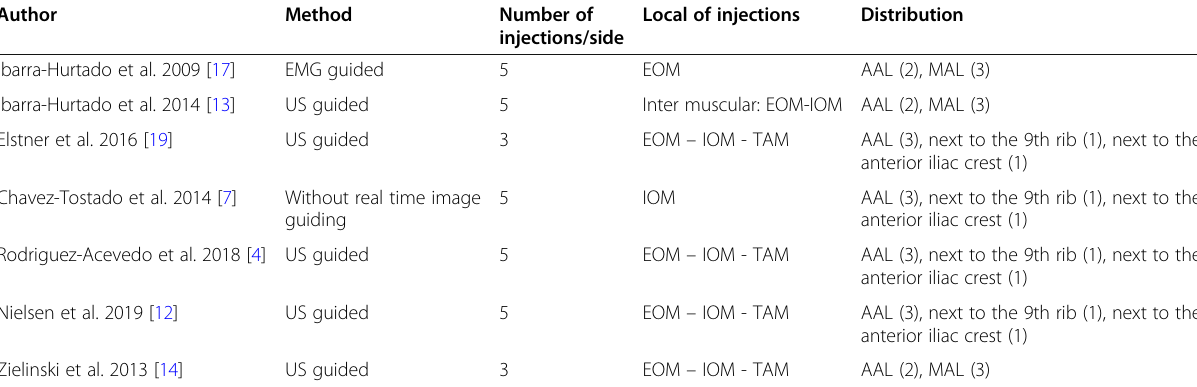
Table 1 BTI methodology to treat CIH: guidance, number, and local of injections